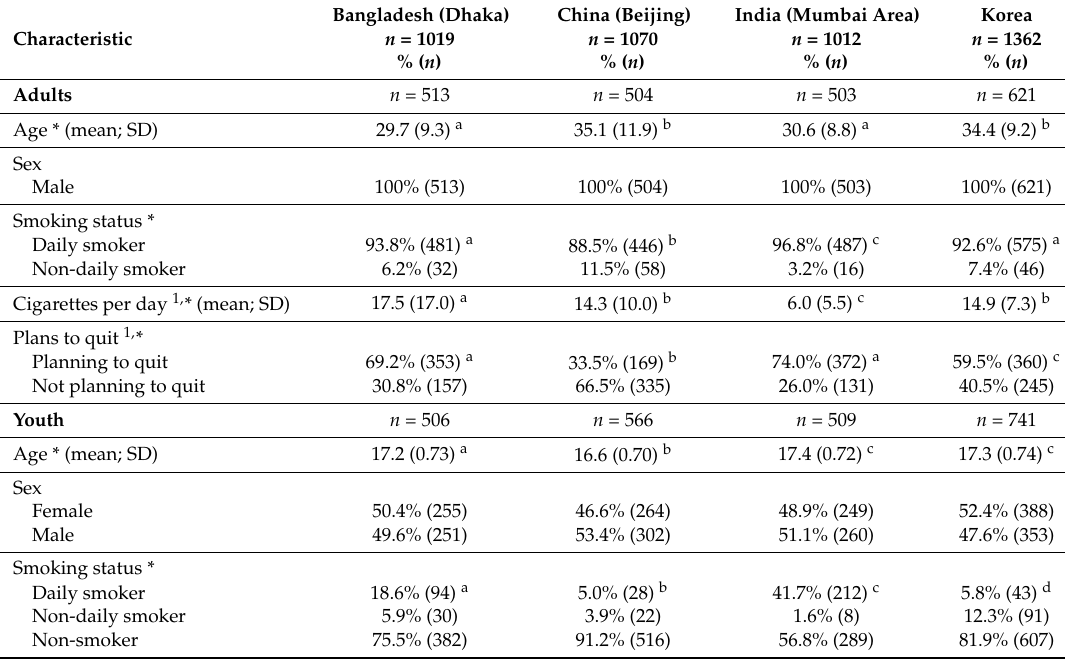
Table 2. Sample characteristics, by country and age group ( n =